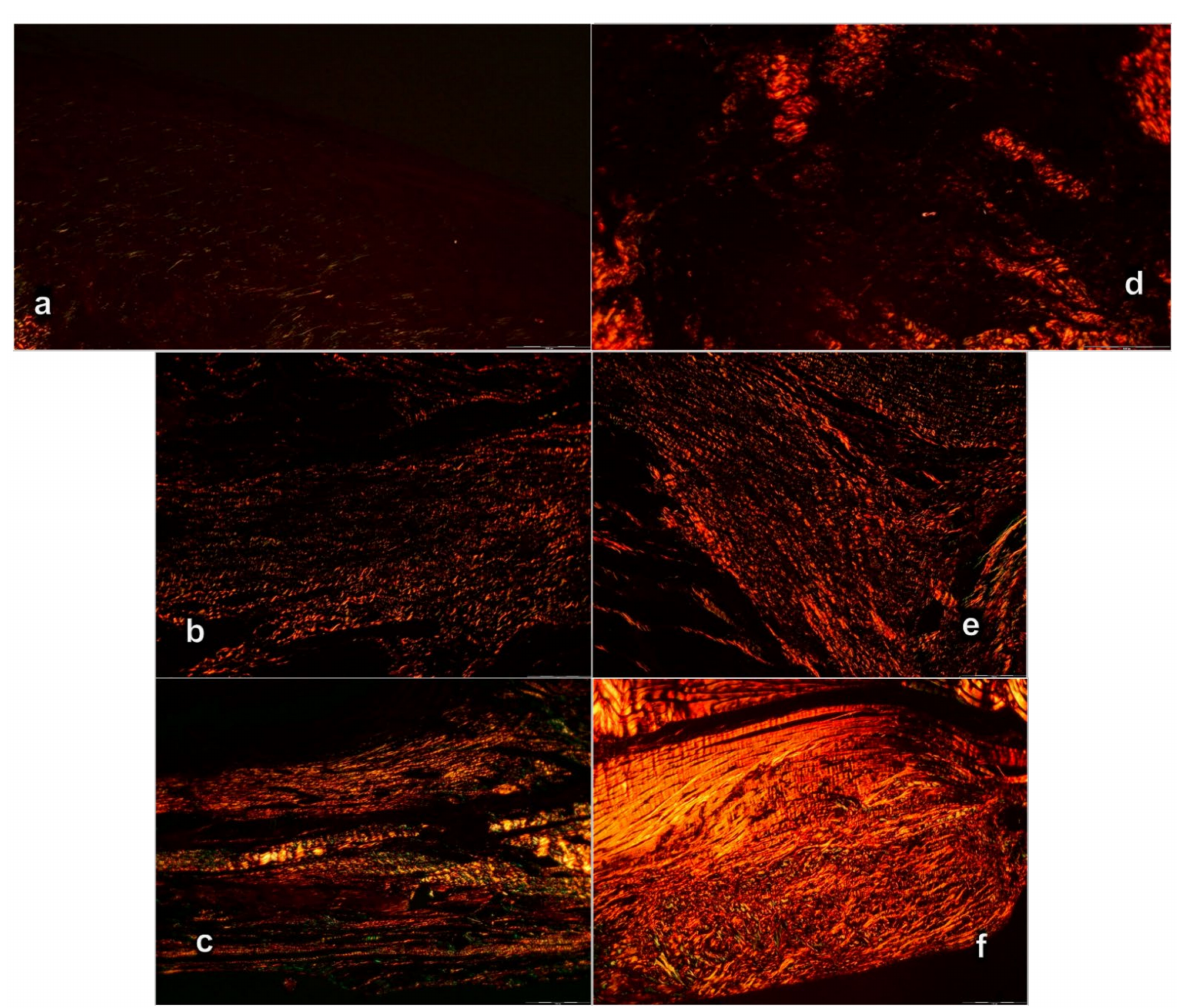
Figure 11. Sirius red histochemical staining with polarized microscopy of myotendinous junction area after myotendinous injury in control ( a – c ) and BPC 157 treated rats ( d – f ). Day 7 ( a , b ), day 14 ( b , e ), and day 28 ( c , f ) (Sirius red staining, magnification ×